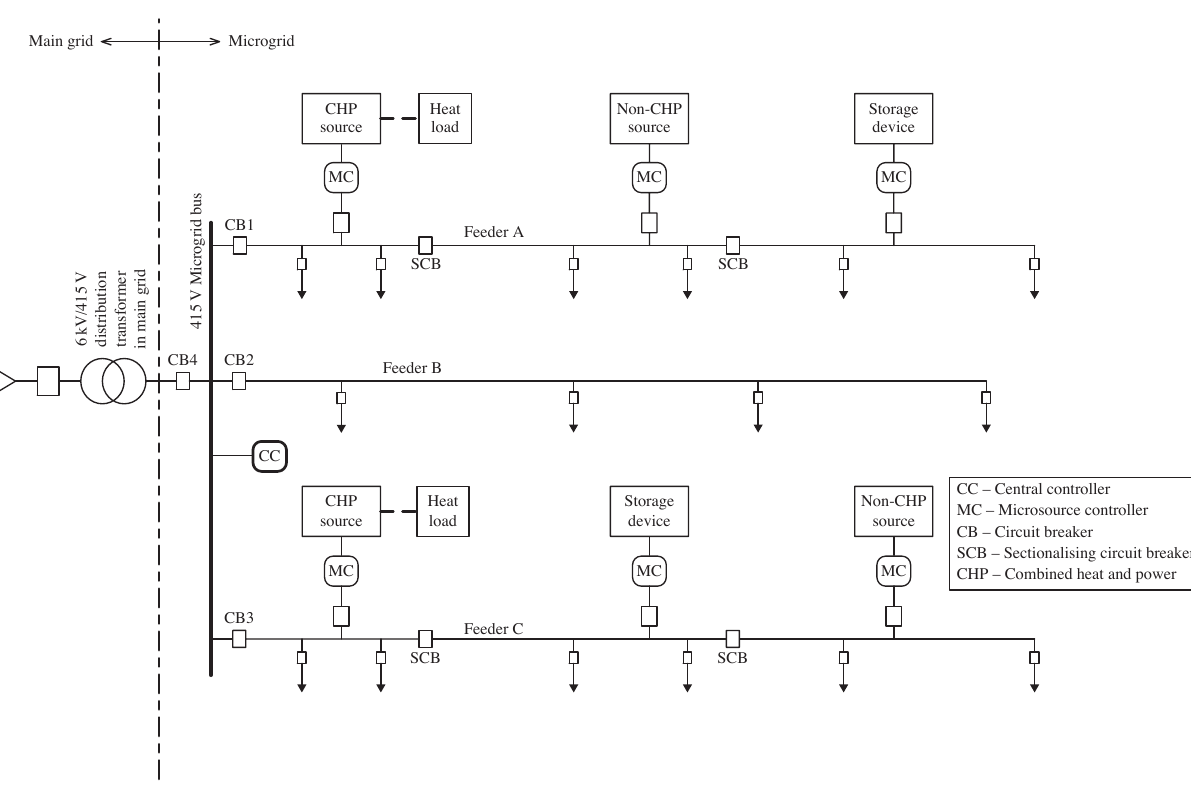
Figure 1. A typical microgrid configuration